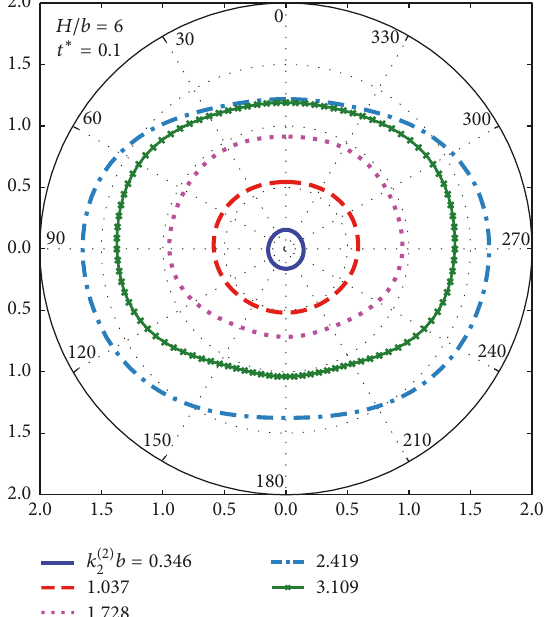
Figure 9: Radial stress (𝜎 ∗ 𝑟𝑟 ) versus polar angle at 𝑟 = 𝑏 for different wave numbers (𝑘 (2) 2 𝑏) for a tunnel in soft soil.